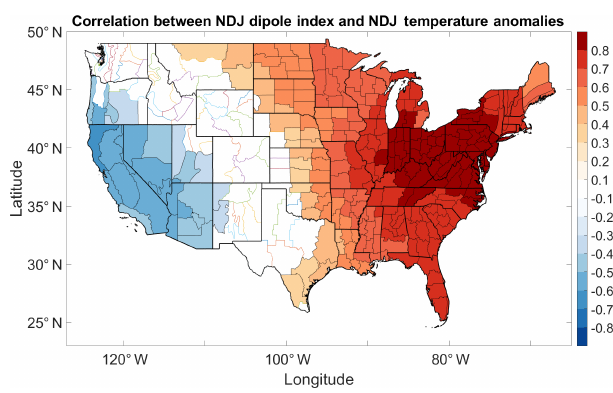
Figure 9. Correlation between the NDJ dipole index and NDJ tem- perature anomalies. Shaded climate divisions are those for which the corresponding correlation coefficients are statistically signifi- cant at the 5% significance level.